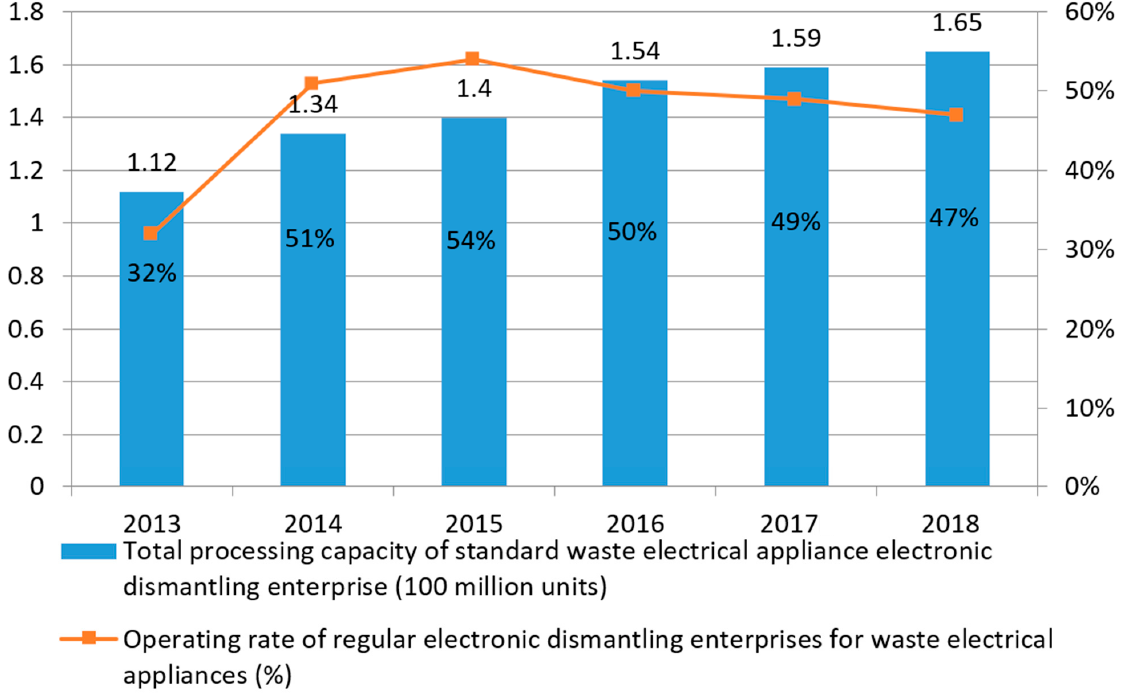
Figure 9. Capacity and operating rate of normal recycling and processing enterprises for WEEE in China (unit: 100 million units, %).